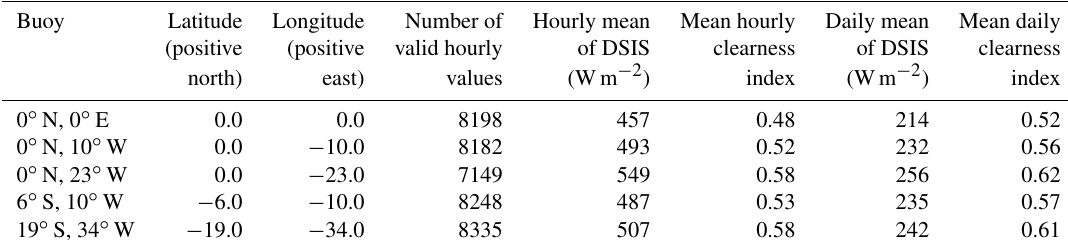
Table 1. Geographical coordinates of the PIRATA buoys used in this study, number of hourly values in each time series, hourly and daily means of valid data in DSIS and clearness indices for the period 2012–2013. Buoy Latitude Longitude Number of Hourly mean Mean hourly Daily mean Mean daily (positive (positive valid hourly of DSIS clearness of DSIS clearness north) east) values (Wm − 2 ) index (Wm − 2 ) index 0 ◦ N, 0 ◦ E 0.0 0.0 8198 0 ◦ N, 10 ◦ W 0 ◦ N, 23 ◦ W